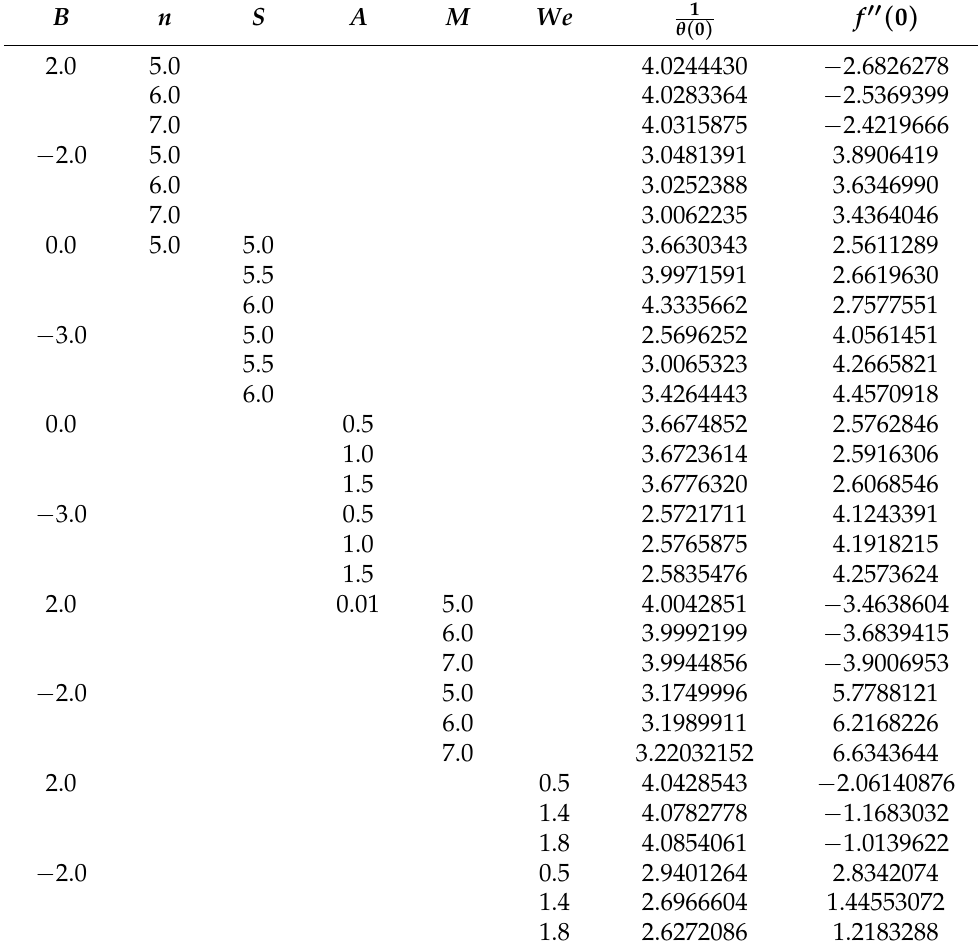
Table 2. Skin friction and Nusselt number at wall, ξ = 0.